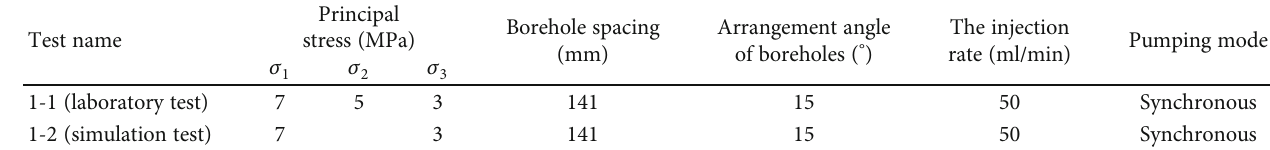
Figure 4: True triaxial hydraulic fracturing test system. Table 2: Experimental scheme of directional hydraulic fracturing controlled by dense linear